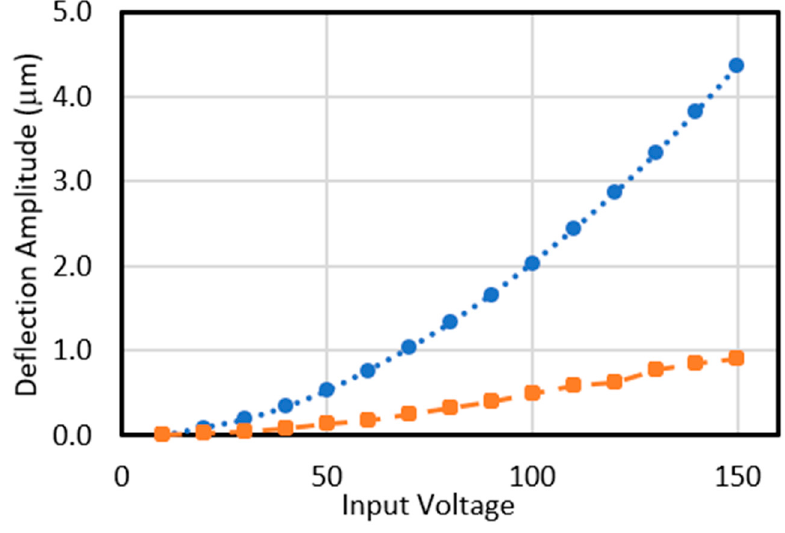
Figure 9. COMSOL simulation results presenting the effect of the input voltage on the upward (blue, circle) and downward (orange, square) deflections of the designed micromirror with a gap 2.75 µm.